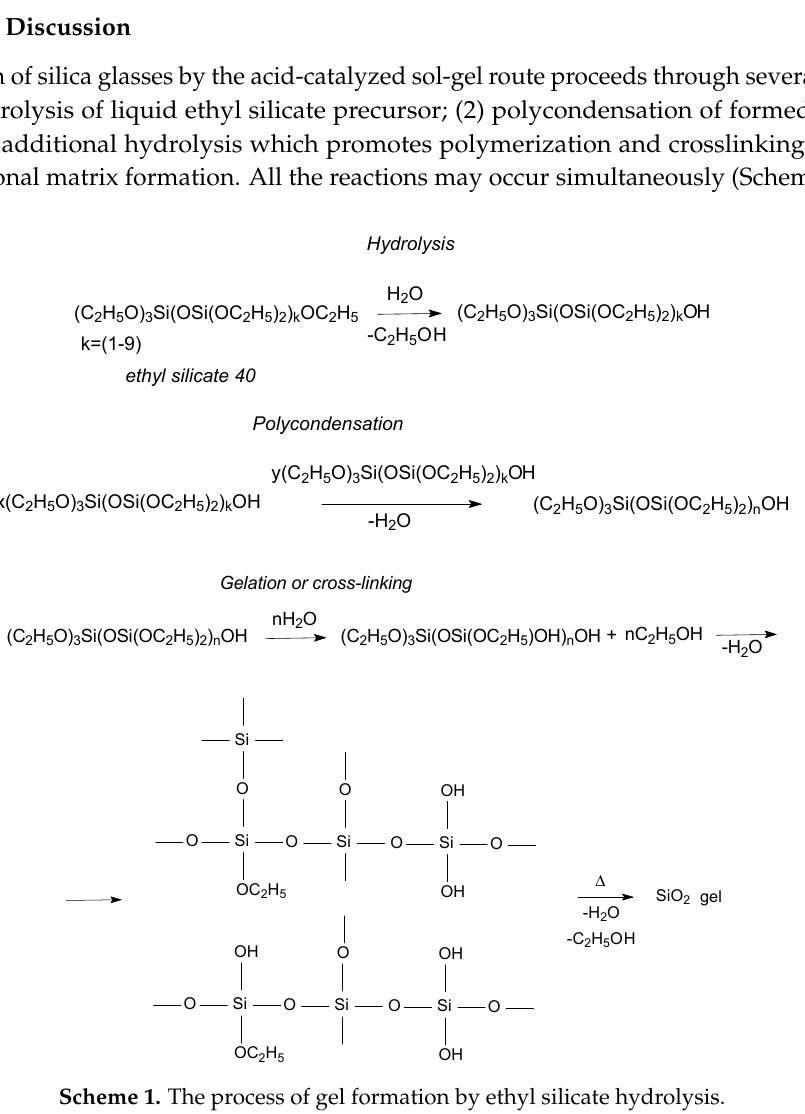
Scheme 1. The process of gel formation by ethyl silicate